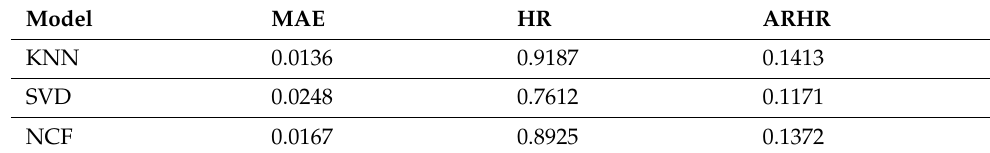
Table 2. Performance evaluation of different models (in units) in 70:30 training–testing ratio. Model